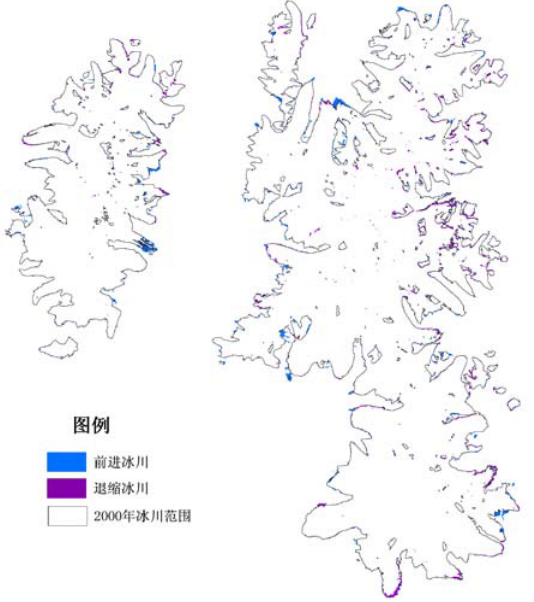
Figure. 3 Extracted Glacier area boundary in Geladandong region in the year 2000. Blue patches represent advanced glaciers, while purple denotes glacier retreatment between 2000 and 2007.